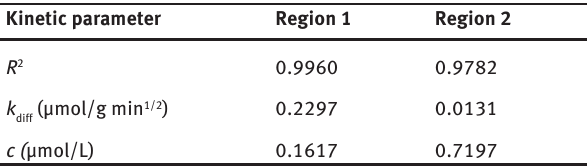
@Cr(VI)-IIL at temperature 2